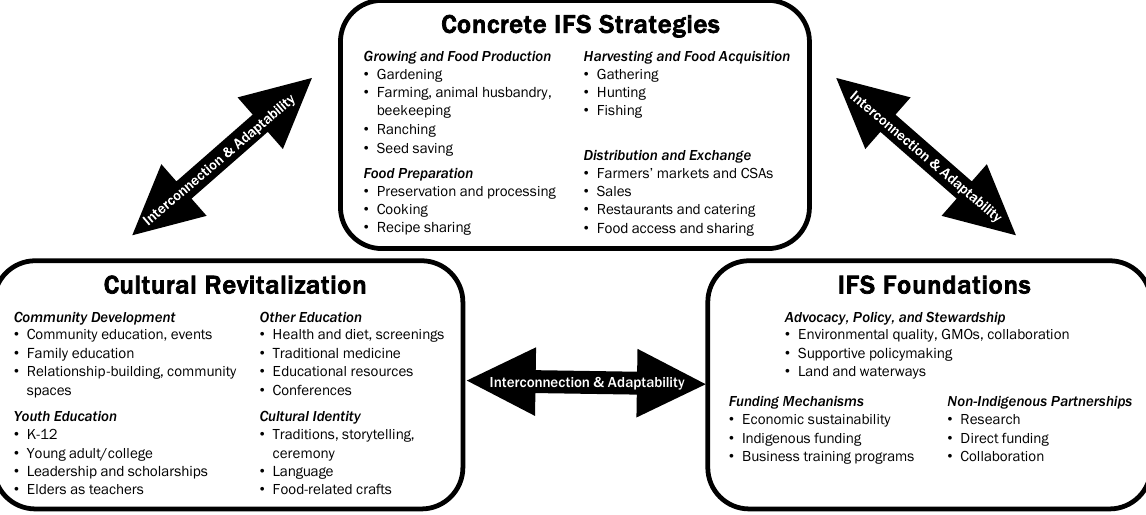
Figure 4. Common Themes and Key Features of Western U.S. Indigenous Food Sovereignty (IFS)